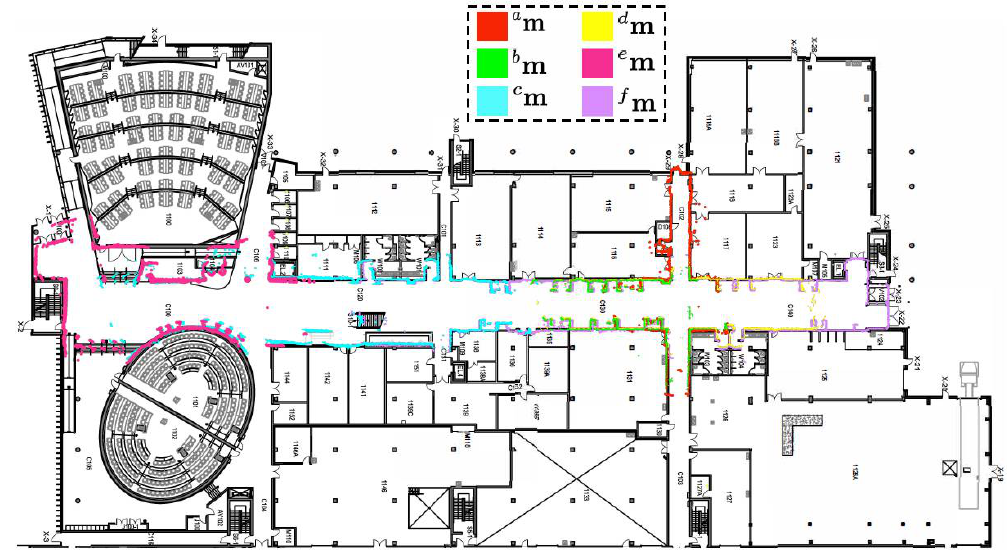
Figure 13. Map fusion hierarchy. The six heterogeneous local maps obtained from individual robots are hierarchically merged into a consistent global map.